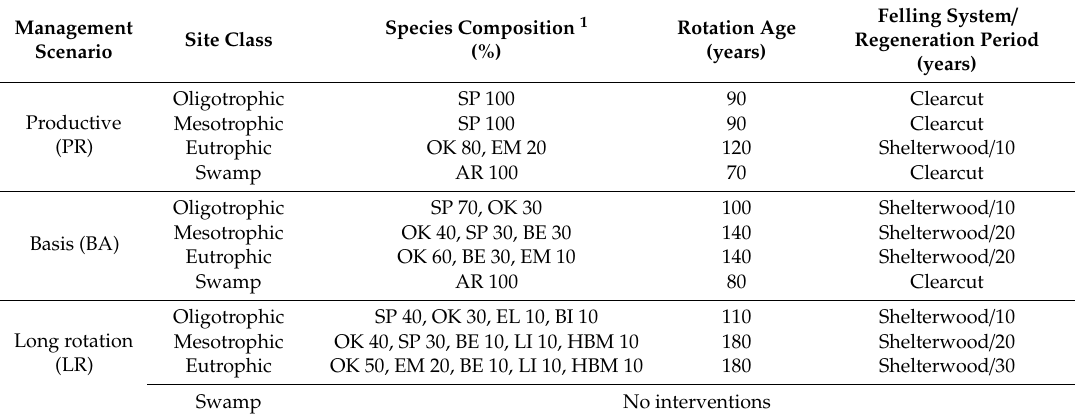
Table 2. Species composition, rotation age, and felling system in di ff erent management